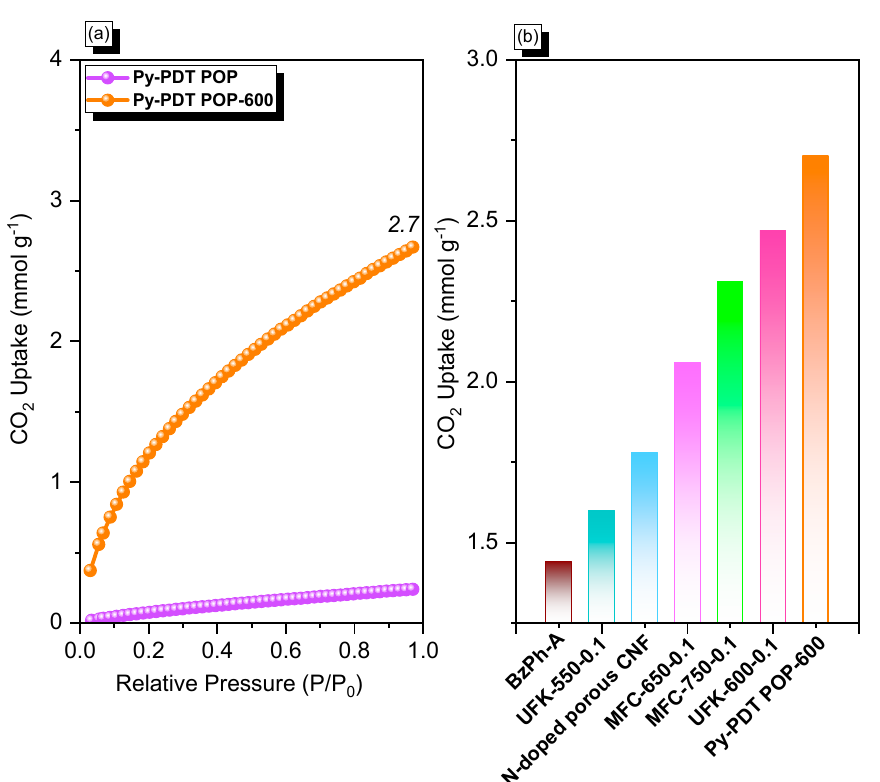
Figure 6. CO 2 capacity ( a ) of Py-PDT POP and Py-PDT POP-600 and their performance compared with other materials ( b ).